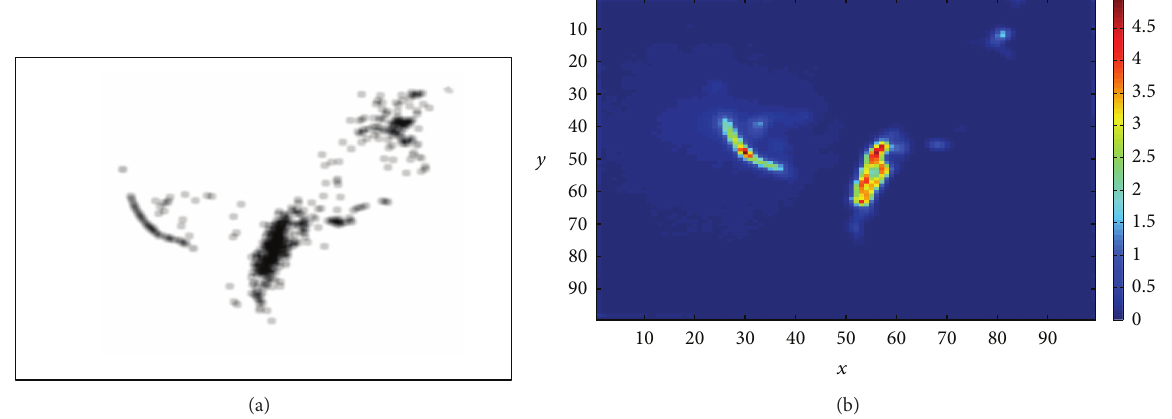
Figure 10: (a) Map ( 𝑀 ) generated from GNOME data for 𝑡 = 140 h. (b) Probability that a robot is in a certain position of the space at 𝑡 = 140 h. Sampled using the macroscopic model of the swarm with the Fokker-Planck